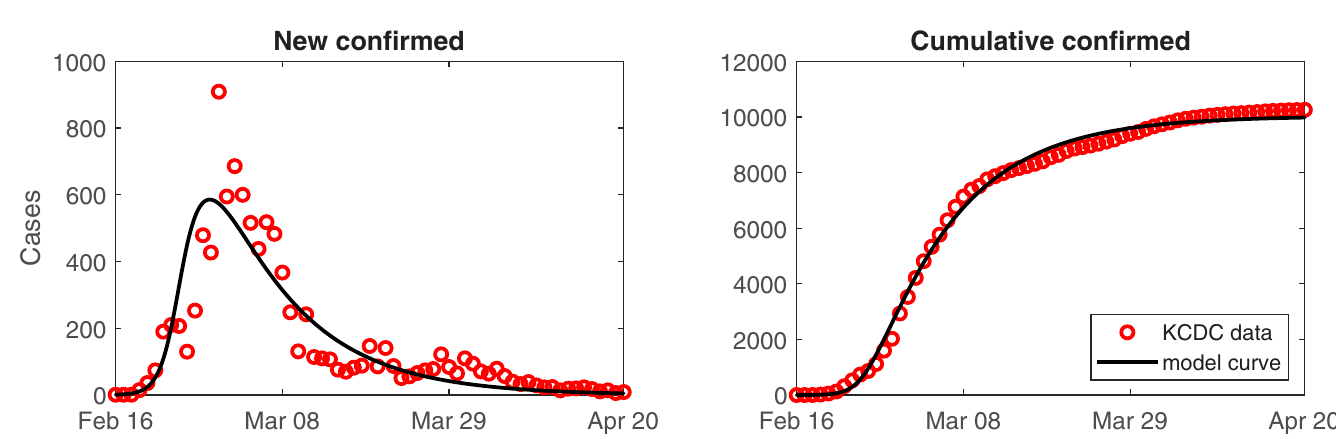
Fig 2. The number of confirmed reported cases and the corresponding best-fit curve: Daily (left) and cumulative (right) number of confirmed cases.